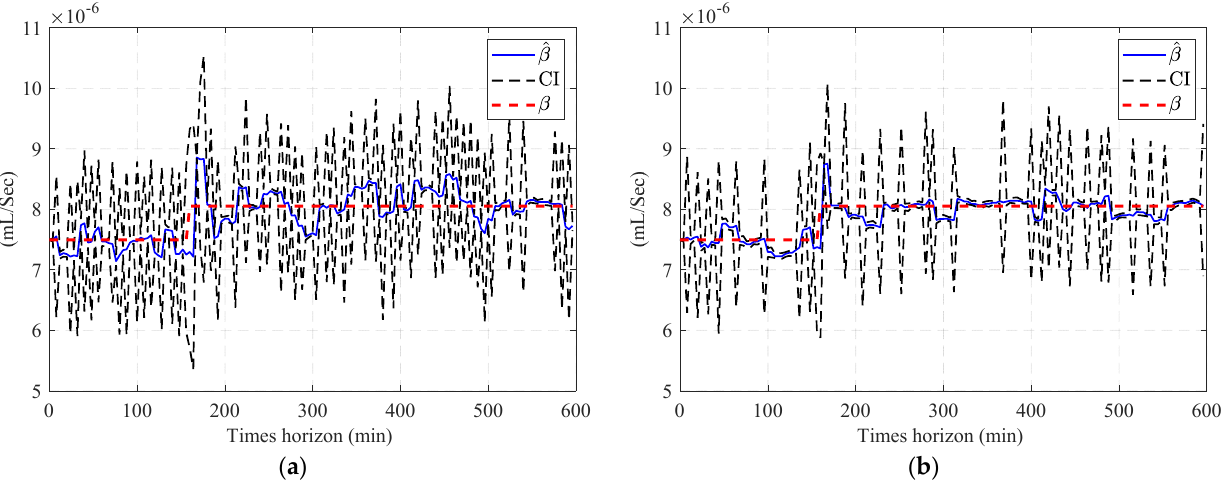
Figure 17. Result of the estimated 𝛽(cid:4632) using the two-step method and estimated the lubricant’s temperature via: ( a ) PF and ( b ) APF.